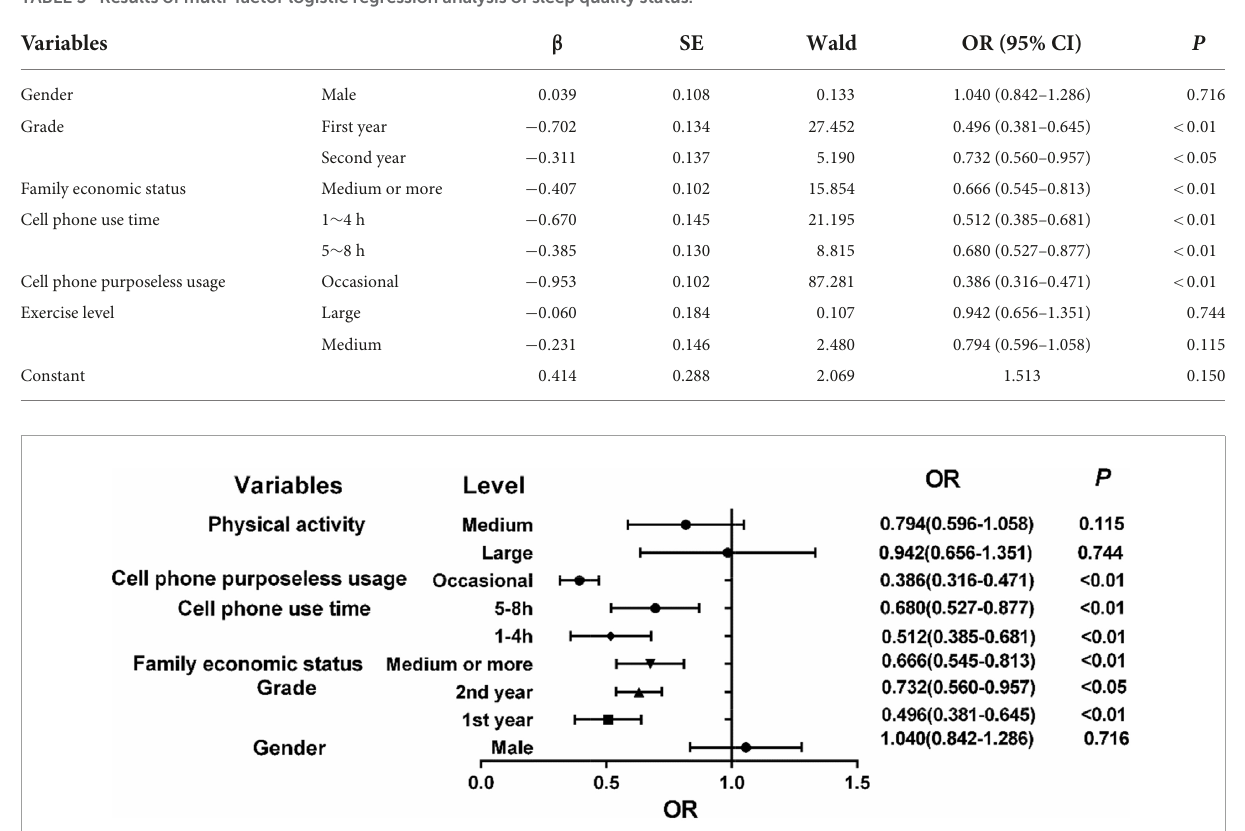
TABLE 5 Results of multi-factor logistic regression analysis of sleep quality status.